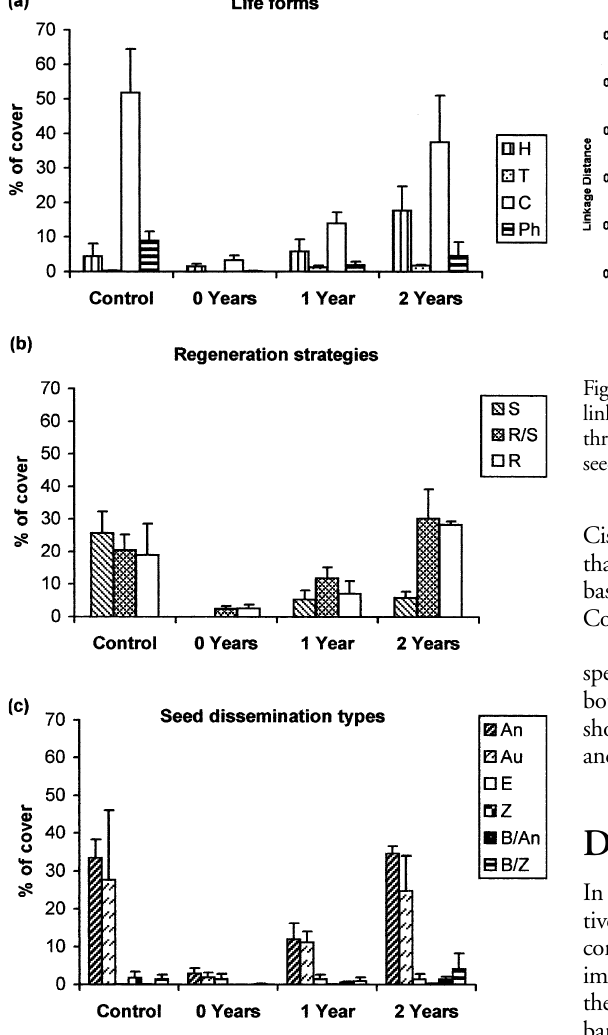
Fig. 2. Mean percentage of cover and SE of traits of species present in the aboveground vegetation in the control situation and in time after fire (0, 1, 2 yr). Life forms (a): H = Hemicrypto- phytes, T = Therophytes, C = Chamaephytes, Ph = Phanero- phytes. Regeneration strategies (b): S = Seeders, R = Resprouters, S/R = Seeders and resprouters. Seed dispersion types (c): An = Anemochory, Au = Autochory, E = Epizoochory, B = Barochory, Z = Zoochory.